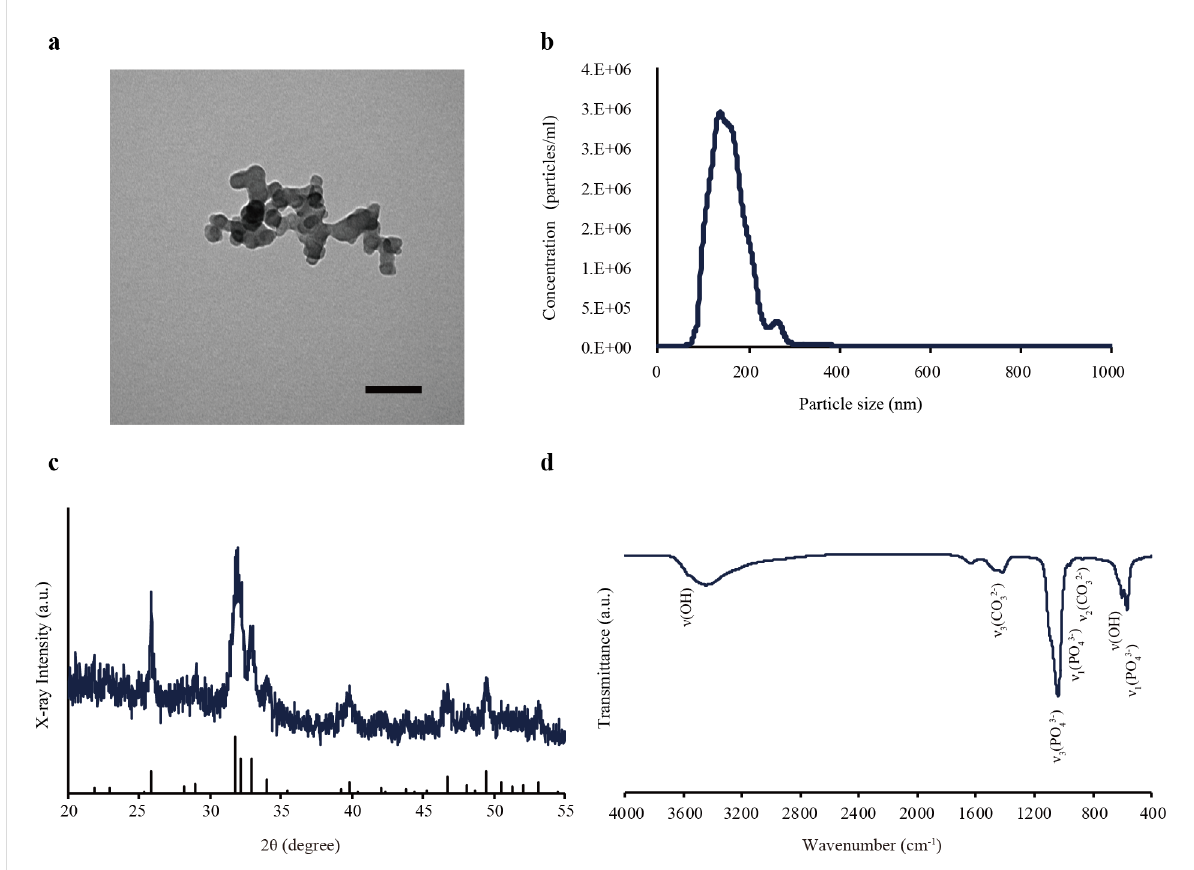
Figure 1: Characterization of the prepared HAp nanoparticles using the W/O emulsion method. (a) A representative TEM image of HAp nanoparticles. The nanoparticles exhibited uniform size and spherical-like morphology. Scale bar: 100 nm. (b) The size distribution of HAp nanoparticles was deter- mined using nanoparticle tracking analysis (NTA). The mean diameter was 159 ± 47 nm. (c) An X-ray diffractogram of the HAp nanoparticles in the range of 2 θ = 20–60°. The spectra revealed the characteristic peaks of HAp according to ICDD no. 09-0432 (vertical lines). (d) The FTIR spectra of